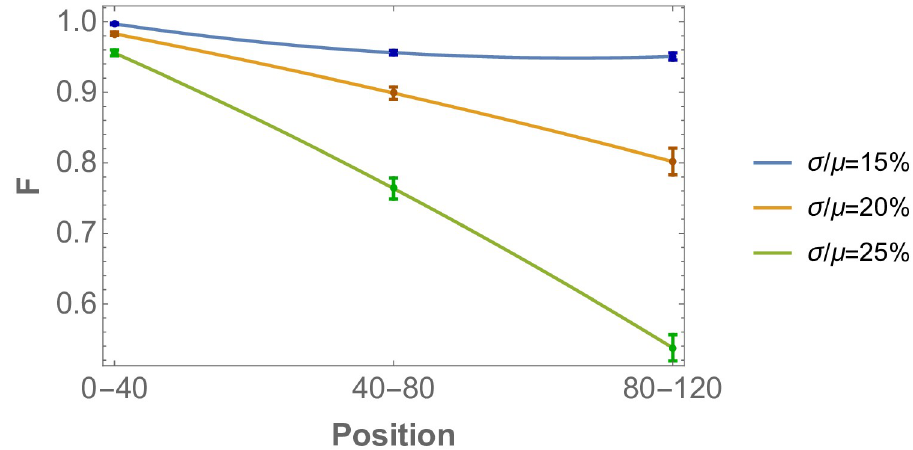
Fig 12. Decay of R8 pattern order as a function of position on the eye disc (same parameter set as in Fig 5). The local order measure is calculated as a function of position, from posterior to anterior. The x-axis refers to regions of the simulated eye disc 0-40, 40-80, 80-120 respectively, whereas the y-axis refers to the fidelity probability distance measure applied to nearest neighbor distance distributions. The three colored lines correspond to various stochasticity levels in D u and D s , from σ / μ = 15% to σ / μ = 25% in steps of 5%. Local order generally decreases from posterior to / μ � 20% is crossed, there is a very sharp spatial decay of the order of the pattern, anterior. Once the threshold of σ c signaling the underlying avalanche effect.